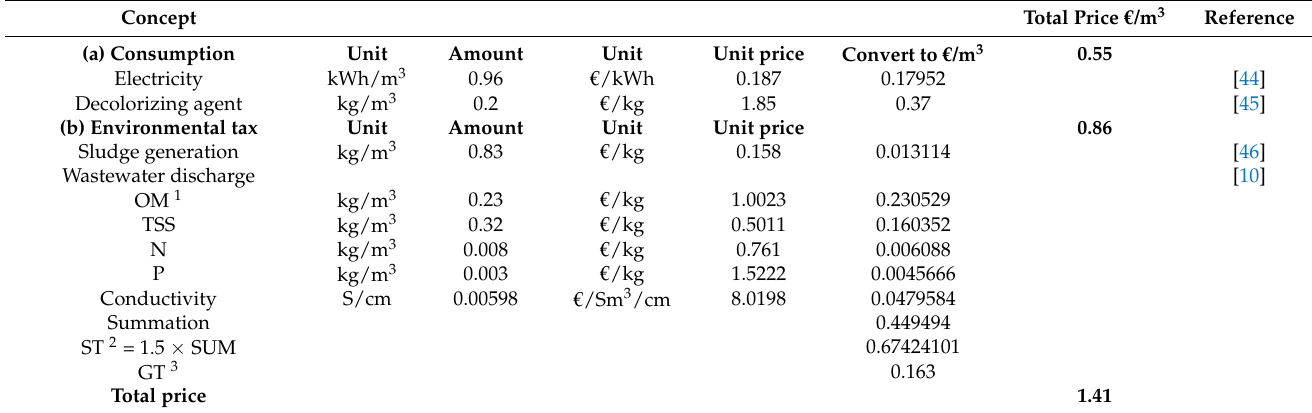
Table 6. CAS operational cost for treating 1 m 3 wastewater.